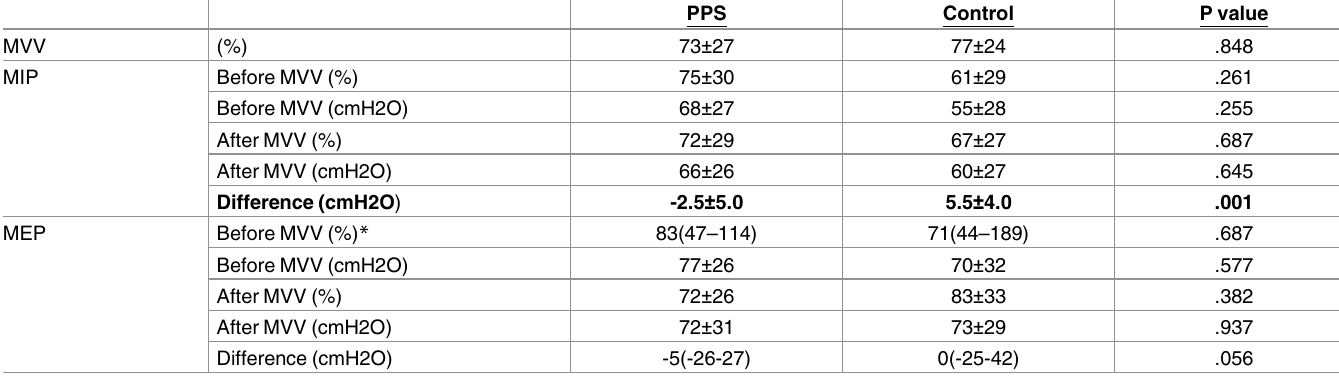
Table 3. Maximal Voluntary Ventilation (MVV), Maximal Inspiratory Pressure(MIP), and Maximal Expiratory Pressure(MEP) in the Post Polio Syn- drome (PPS) subjects (N = 12) and the heathy subjects (N = 12), presented as percent of predicted value. Values are presentedas mean ± standard